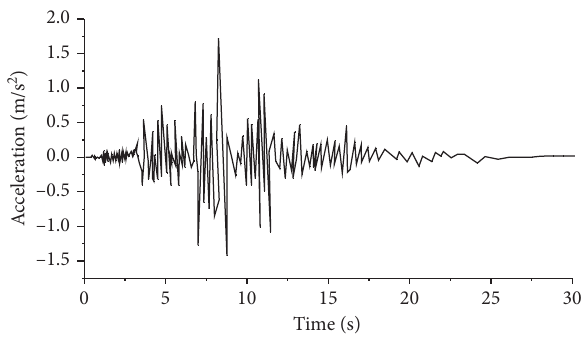
Figure 6: Seismic wave P-waveform.